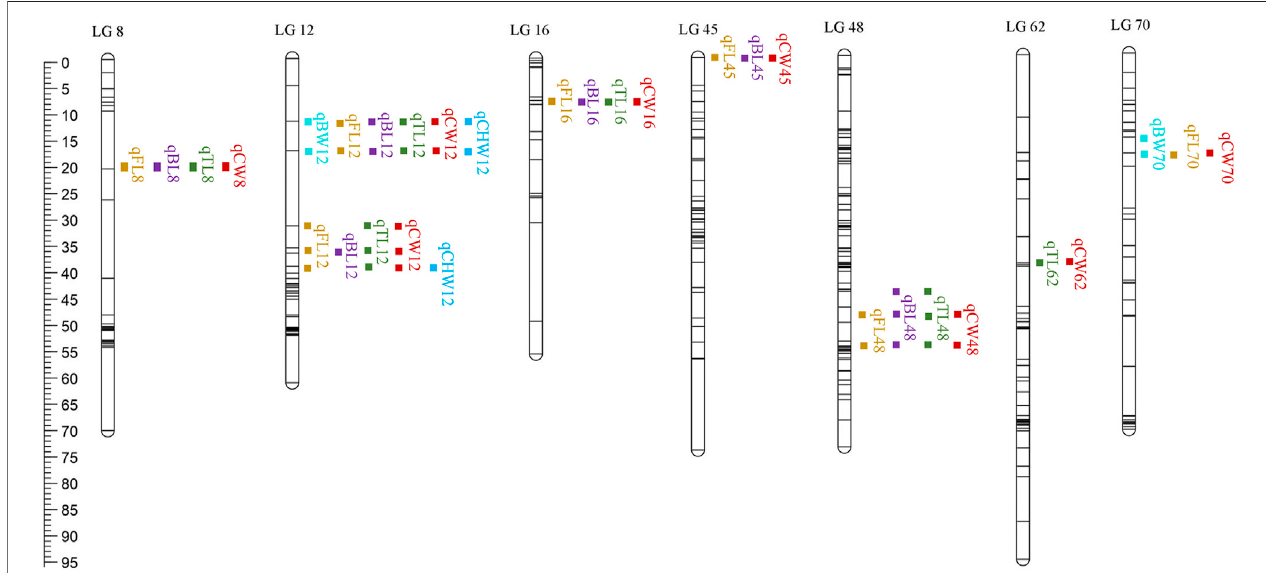
FIGURE 3 | QTL distribution on nine different LGs. The scaleplate on the left indicates genetic distance (centimorgan as the unit).